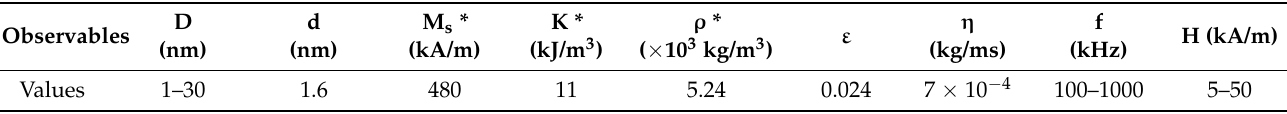
Table 1. The characteristic observables of Fe 3 O 4 – γ -CDs bionanoparticles and the parameters of the alternating mag- netic